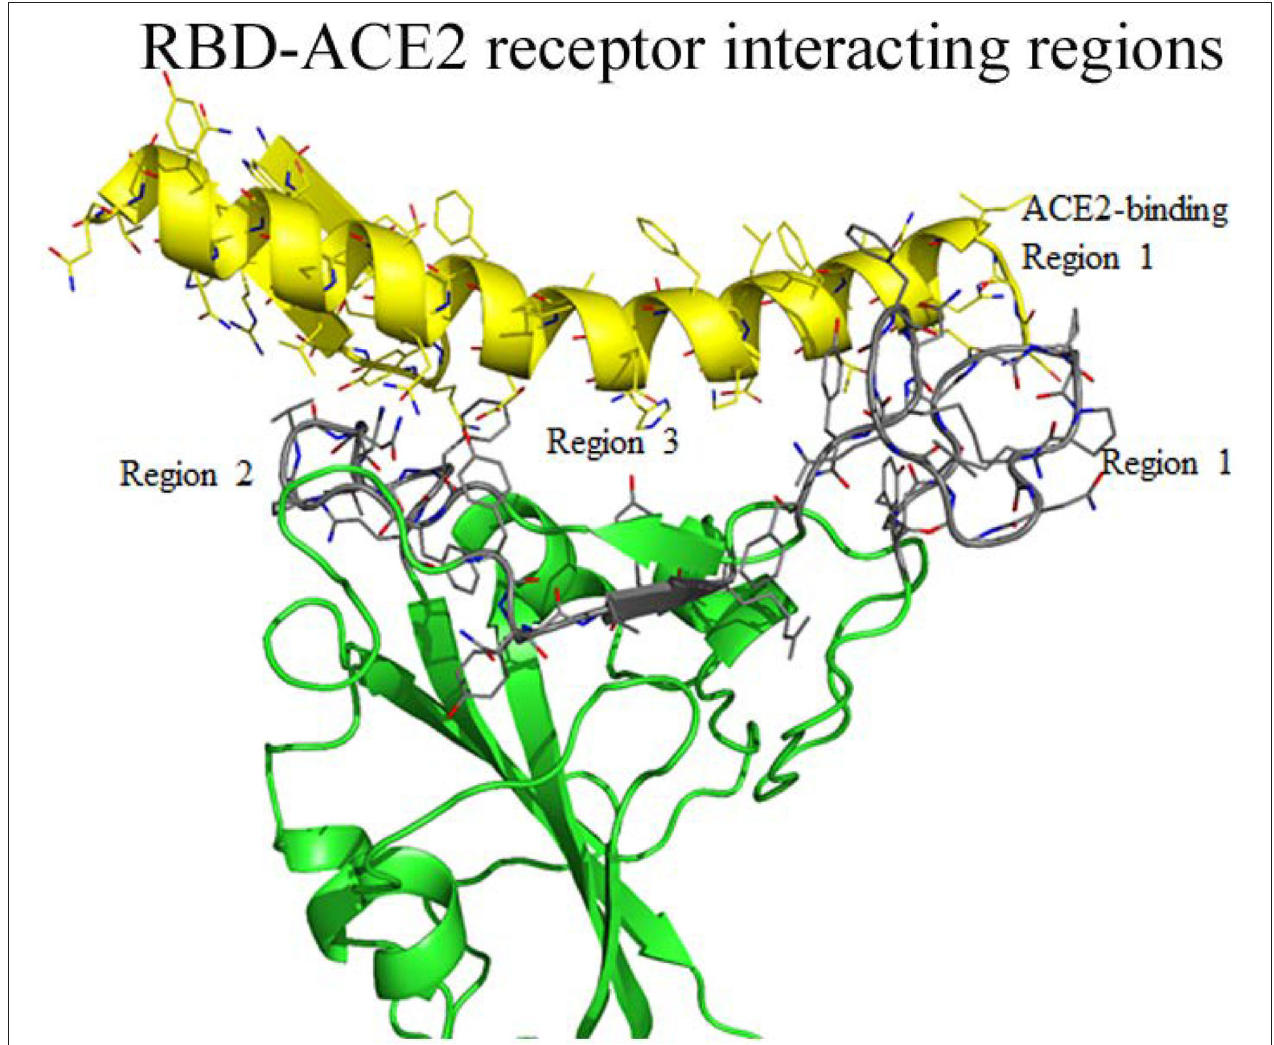
FIGURE 3 | Interaction between regions of RBD of SARS-CoV-2 and the ACE2 receptor molecule. The RBD globular head forms a bowl-shaped structure and both ends are covered with elevated loops. Residues from these loops are positioned to interact with the ACE2 receptors and labeled as ACE2 receptor binding region 1 to 3 and highlighted with gray color. The interacting residues of ACE2 receptor also labeled as region 1 to region